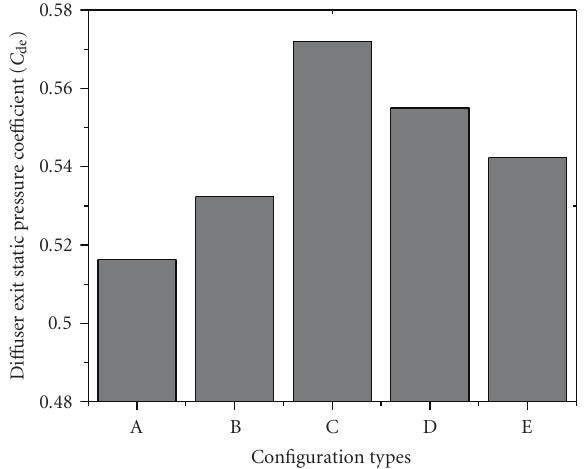
Figure 15: Di ff user exit static pressure coe ffi cient for the various configurations.